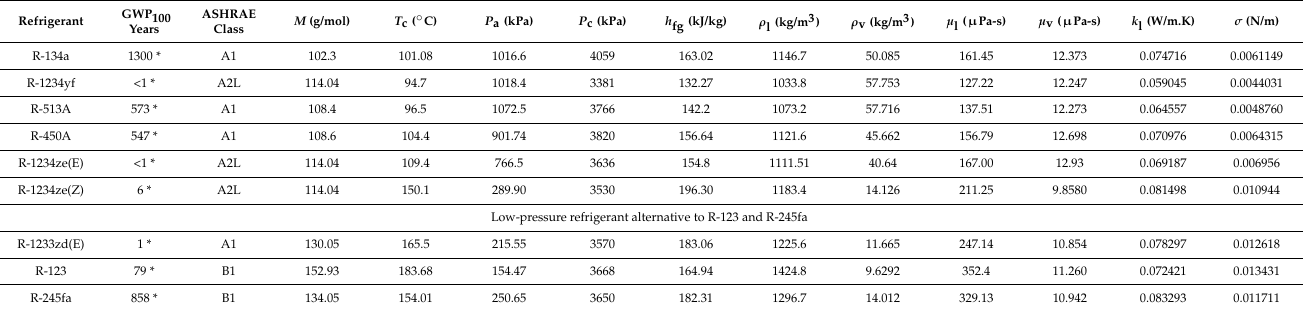
Table 1. Thermodynamic and transport properties of low-GWP refrigerant alternatives to R-134a at 40 ◦ C [1].